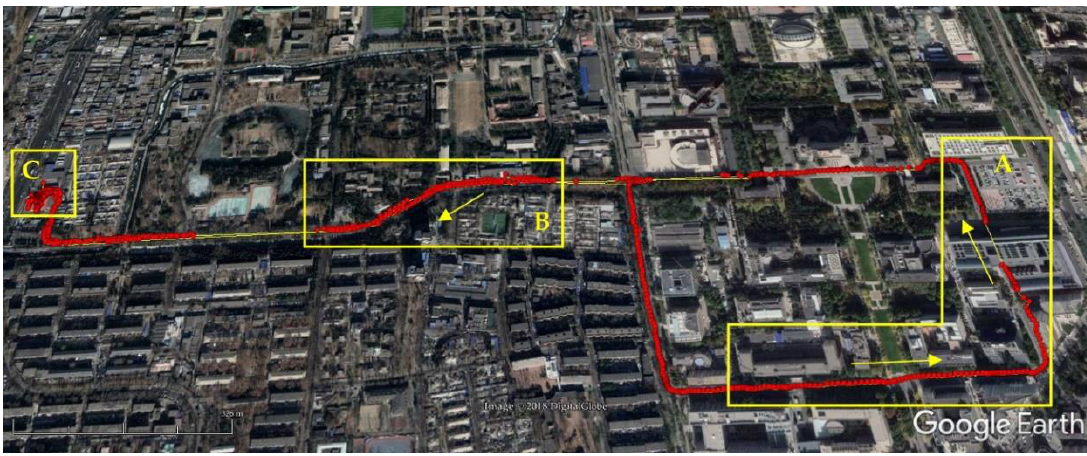
Figure 13. Route of dynamic GNSS/INS integration experiment.